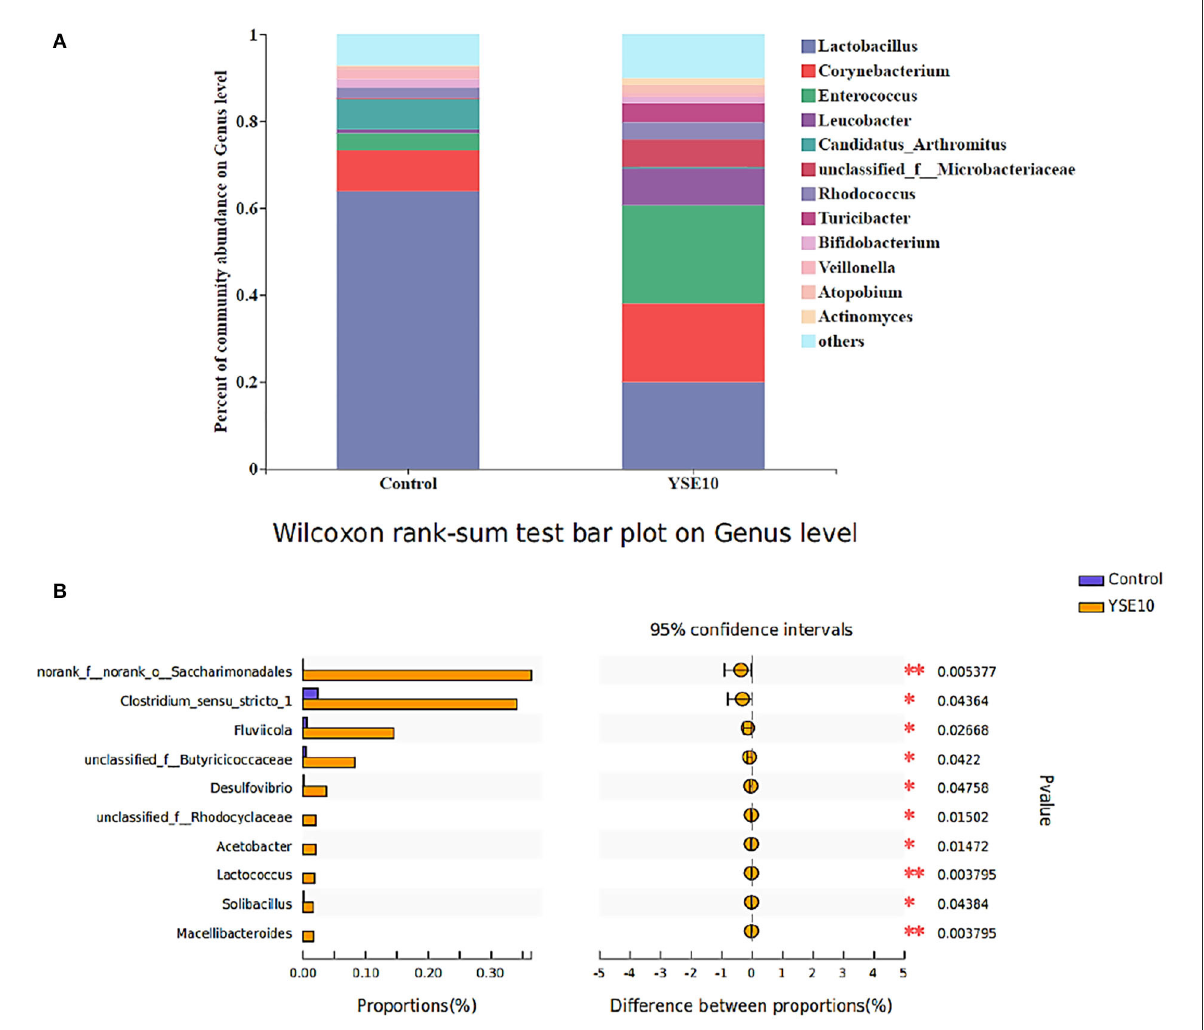
FIGURE2 The composition of microbiota and the comparison of differences at the level of genus in the ileum of young pigeons. (A) Percent of community abundance. (B) Wilcoxon rank-sum test bar plot. The relative abundances of genus in all samples’ sequence < 0.01 are classified as “others”. Control, 0.9% NaCl solution; YSE10, 10 mg/mL